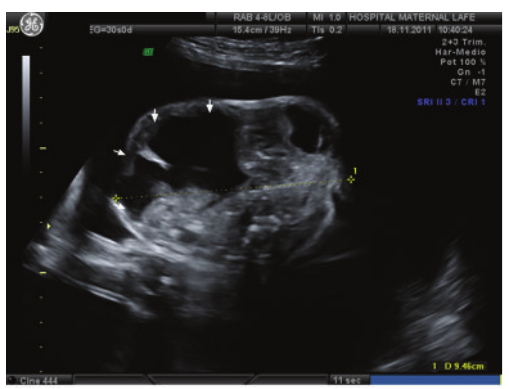
Figure 1: Ultrasound at 22 weeks, where heterogeneous tumor is found in cervical position, moderately vascularized.